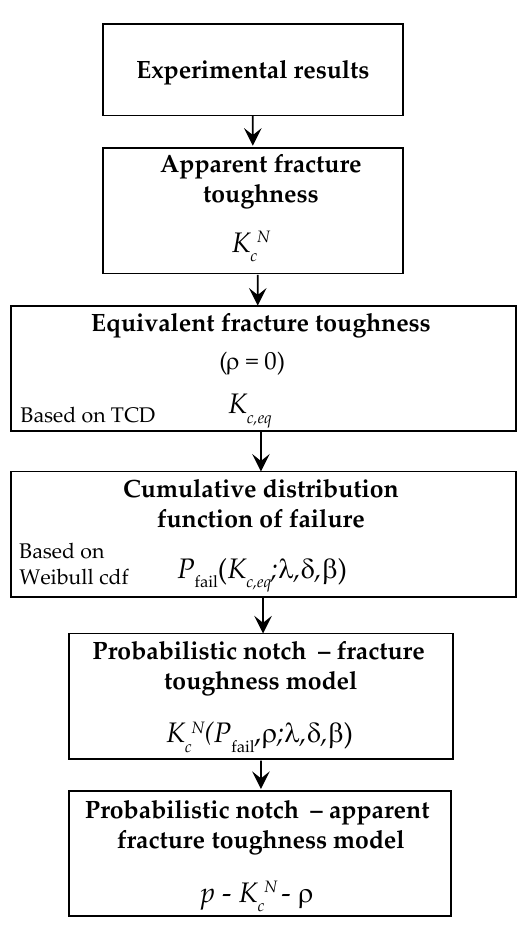
Figure 2. Flowchart of the proposed